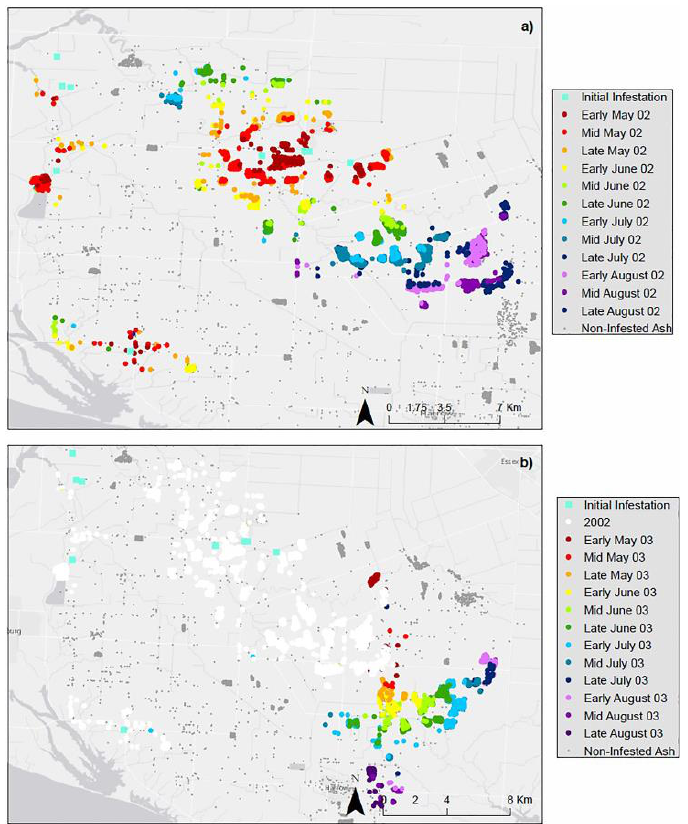
Figure 6. Simulation results of EAB infestation spatial patterns generated for the years ( a ) 2002 and ( b ) 2003 for the Rural Landscape Scenario.